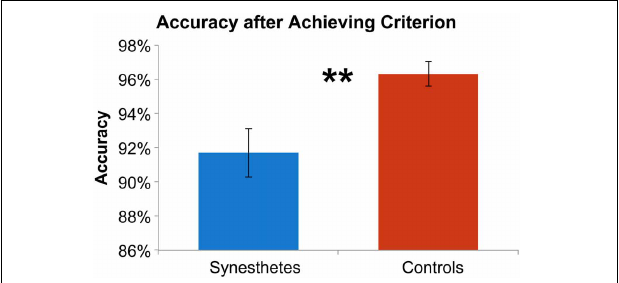
FIGURE 4 | Synesthetes (blue) and controls (red) mean accuracy for trials following reaching criterion. Error bars reflect standard error of the mean and ∗∗ denotes significance at p < 0 .